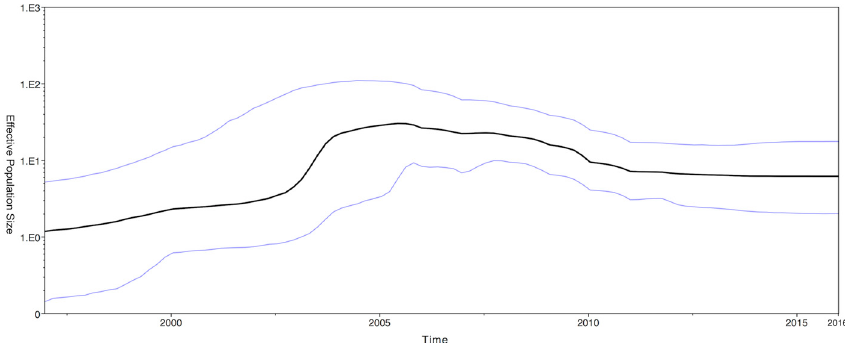
Figure 2. Bayesian skyline plot for the complete VP2 gene of the CPV-2. The x -axis is in units of year before 2016 and the y -axis represents the virus effective population size. The thicker bold line represents the median estimate of the effective number of infections over time and the thinner blue lines indicate the upper and lower bounds of the 95% HPD.